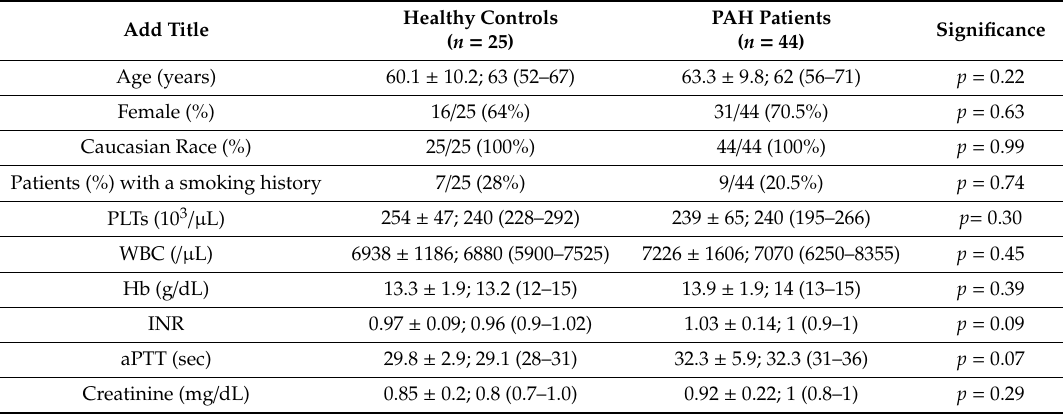
Table 3. Demographics, clinical characteristics and laboratory findings of patients with pulmonary arterial hypertension (PAH) and healthy controls. Hemodynamics of PAH